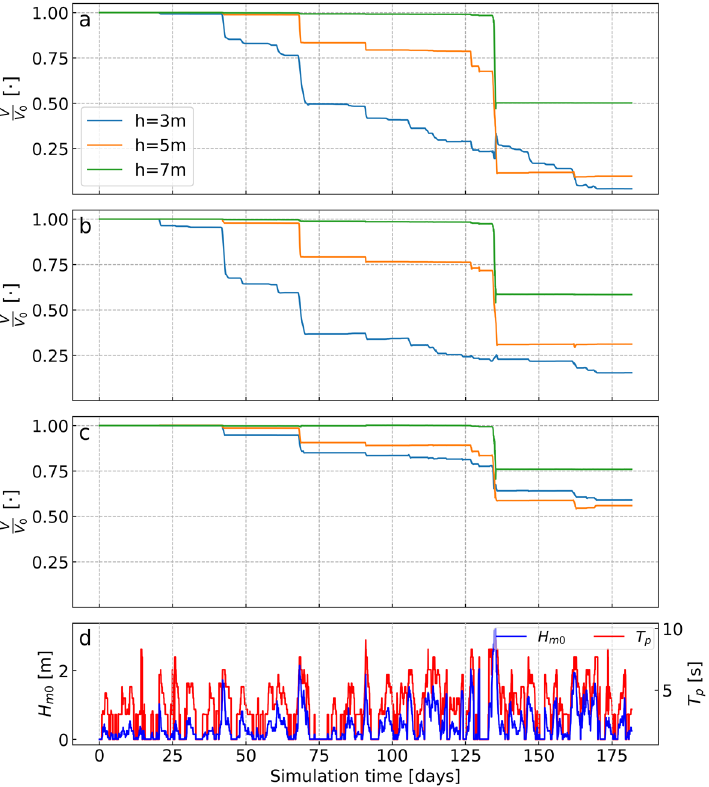
Figure 13. Longevity of nearshore nourishments at the Ogden Dunes site in terms of percent placed volume remaining in original footprint through time where the blue, orange, and green colors represent the 3 m, 5 m, and 7 m placement depths, respectively. ( a ) Linear berm; ( b ) undulated berm; ( c ) discrete mounds; ( d ) time series of offshore zero-moment wave height and peak period.